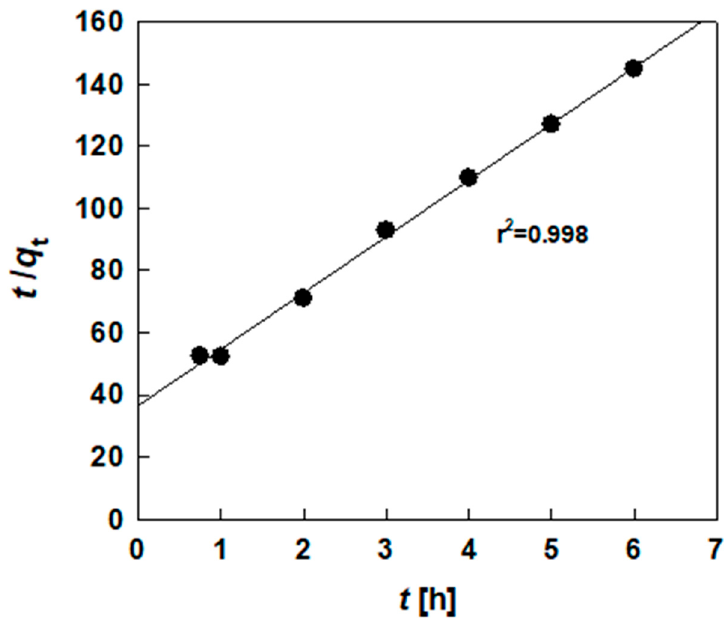
Figure 6. Plot of the pseudo-second-order model based on Equation (2) using data shown in Figure 2.